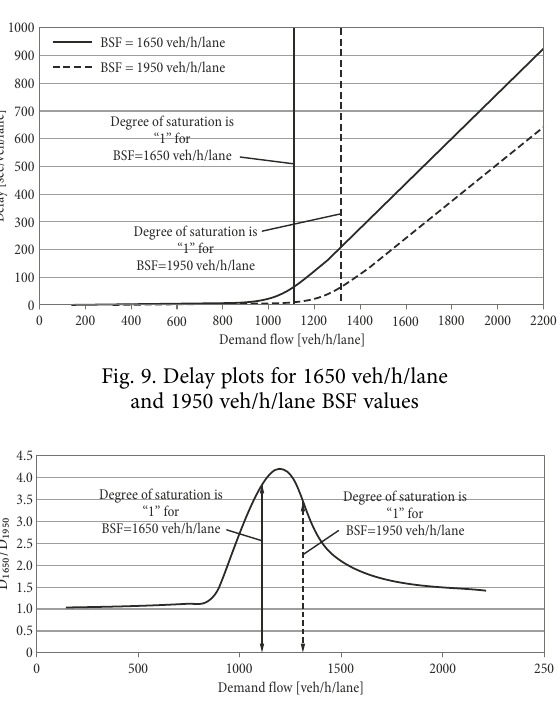
Fig. 10. D 1650 /D 1950 plot with respect to traffic demand flow [veh/h/lane]